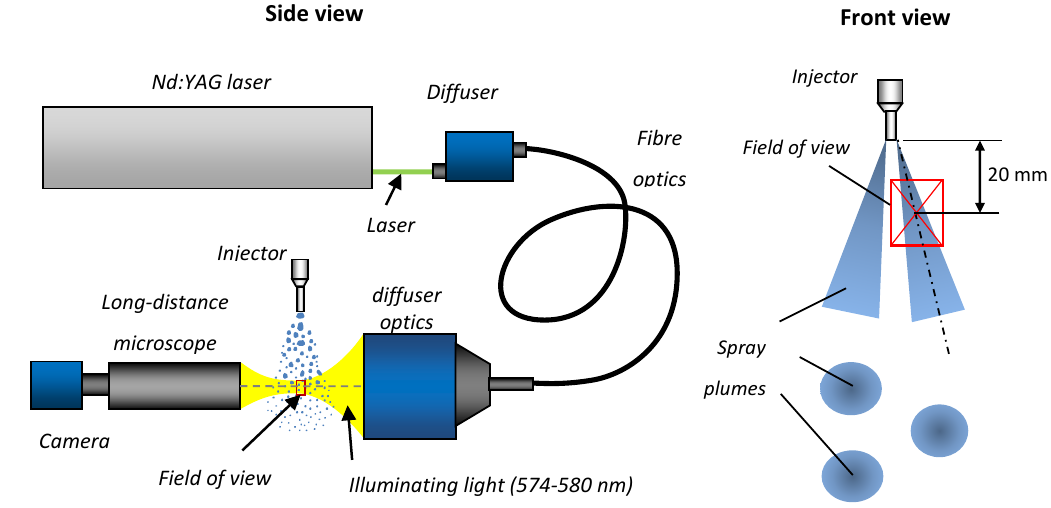
Figure 16. Experimental set-up for shadowgraphy with long-distance microscope.